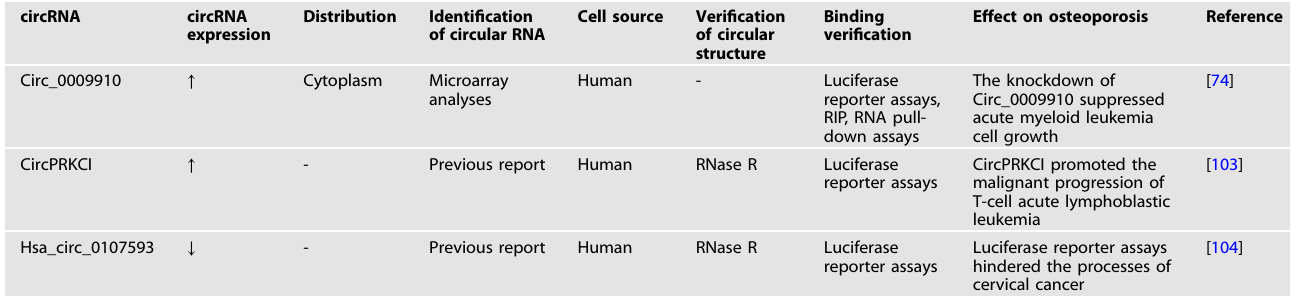
Table 2. circRNA-miR-20a-5p network in regulating